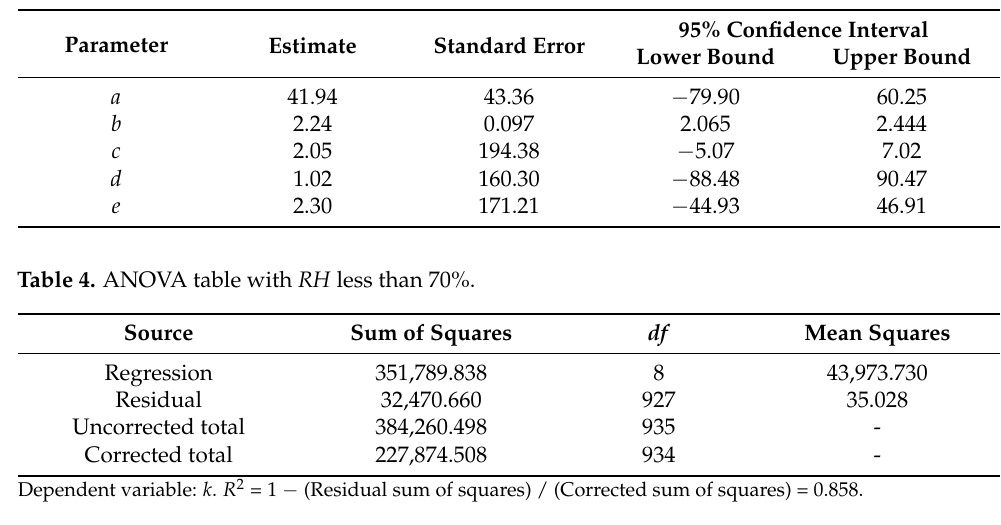
Table 3. Parameter estimates with RH less than 70%.